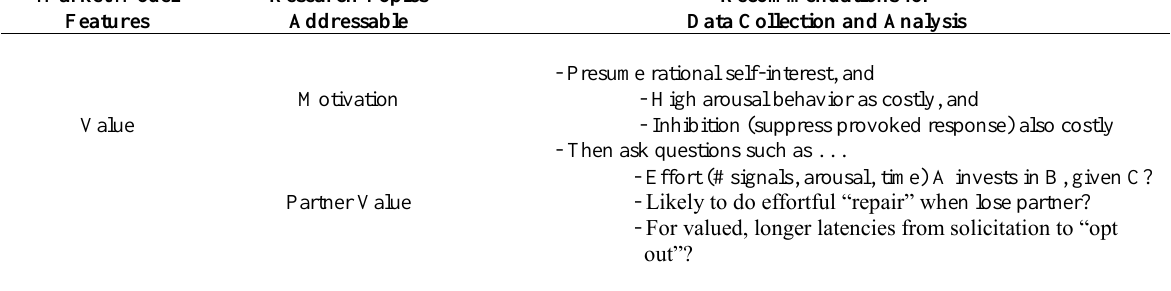
Table 2 Some methodological implications of adopting a market model for studies of dolphin communication and social cognition Market